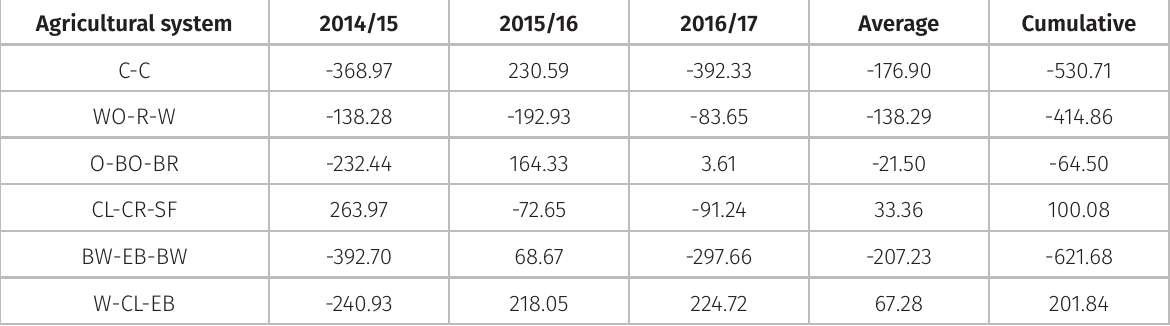
Table V. Opportunity costs (US$ ha -1 ) of each production system for the 2014/15, 2015/16, and 2016/17 crop years, assuming peak quarterly prices.